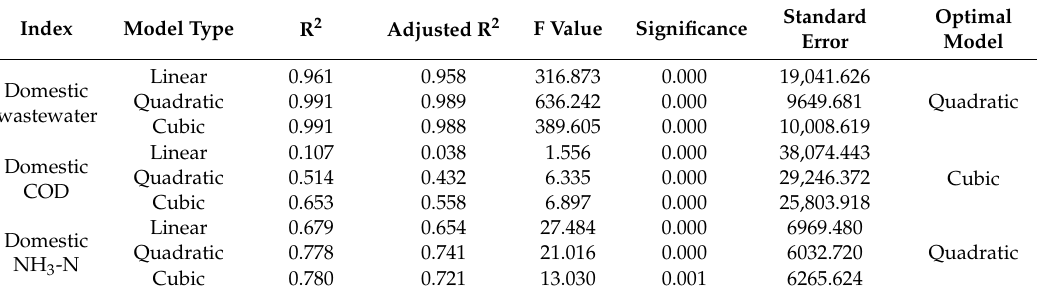
Table 4. Optimal EKC model between domestic pollutants emission and economic